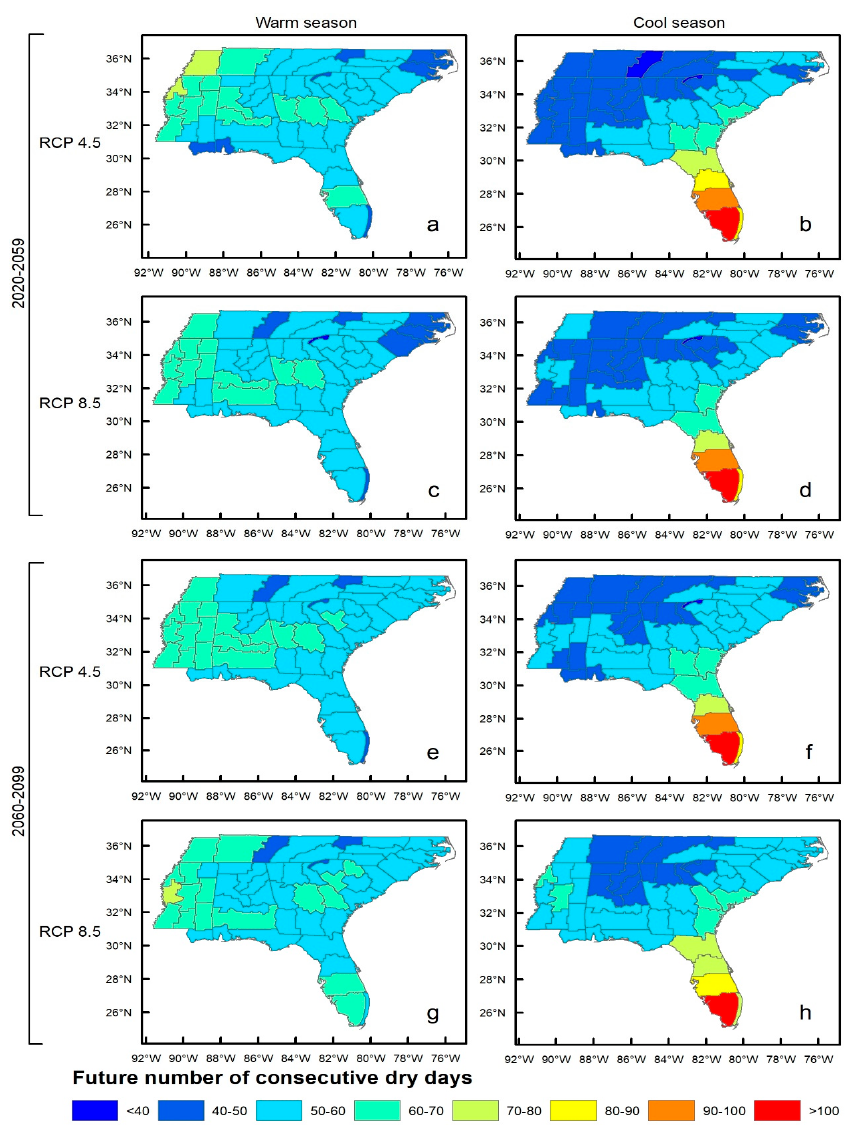
Figure 2. Modeled future length of 20-year return period consecutive dry days. Warm season estimates are shown in ( a , c , e , g ), and cold season estimates are shown in ( b , d , f , h ). Future period and RCP scenario are indicated on the left.